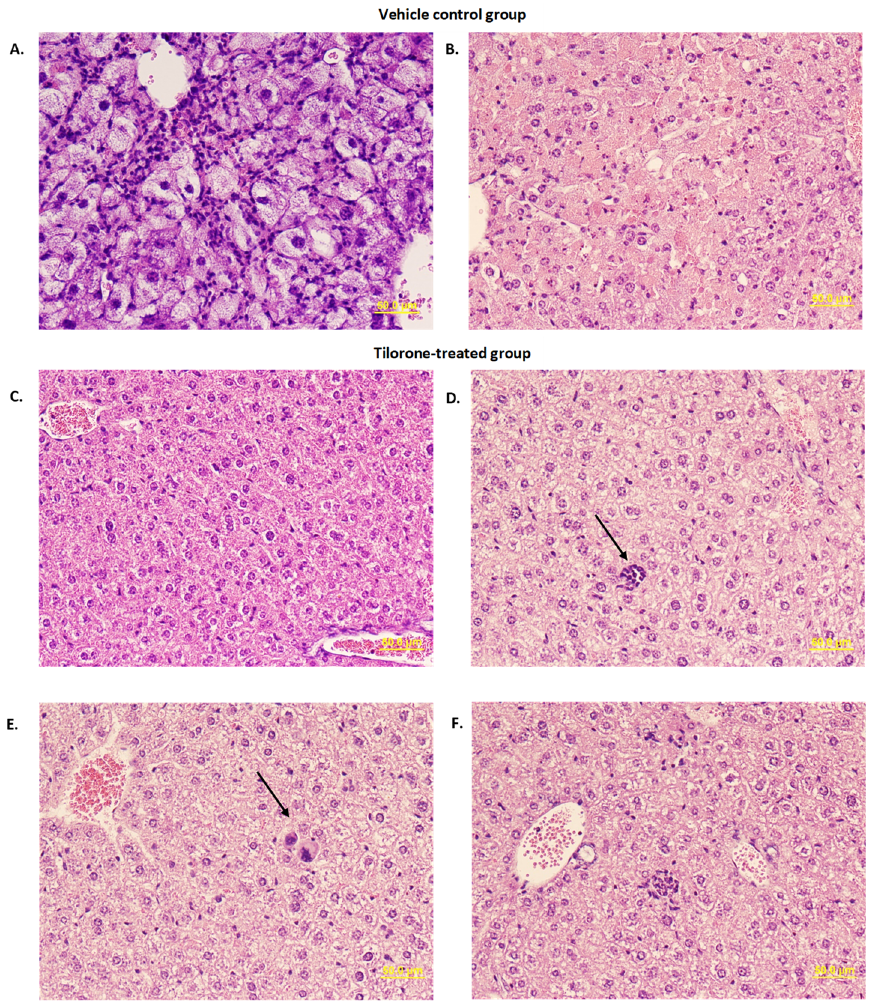
Figure 5. Histopathological changes reduced in Tilorone-treated mice. Formalin fixed tissues were embedded in paraffin and processed for H&E staining. Images represent livers of vehicle control and tilorone-treated mice. ( A ) Ballooned hepatocytes in vehicle-treated control mice at late stage. ( B ) Hepatocyte necrosis in vehicle-treated control mice. ( C ) Normal liver from Tilorone-treated survivor. ( D ) Erythroid cells in liver from Tilorone-treated survivor. ( E ) Megakaryocyte in liver from Tilorone-treated survivor. ( F ) Neutrophil infiltrate in liver from Tilorone-treated survivor.